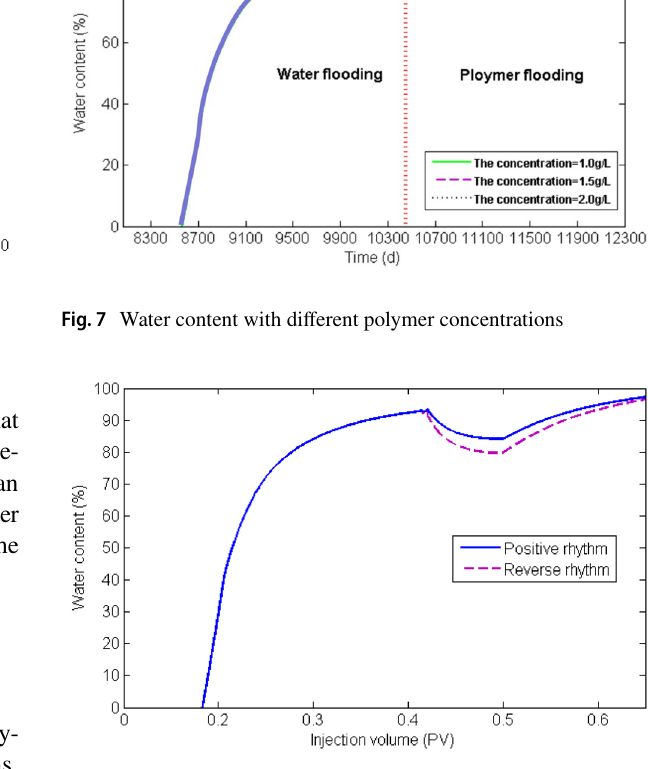
Fig. 8 Water content with a different